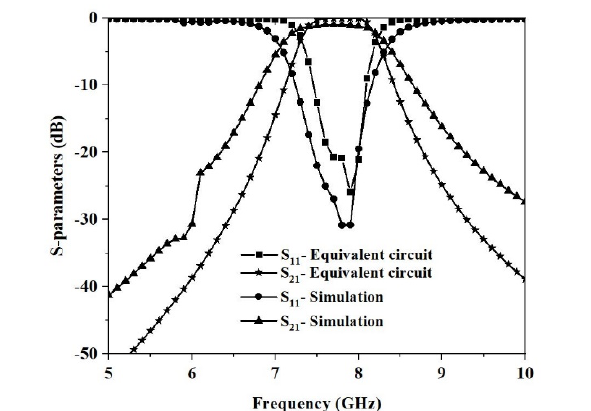
FIGURE.9. S-PARAMETERS OF SYMMETRICAL RING RESONATOR BANDPASS FILTER USING ELECTROMAGNETIC SIMULATION AND EQUIVALENT CIRCUIT SIMULATION.